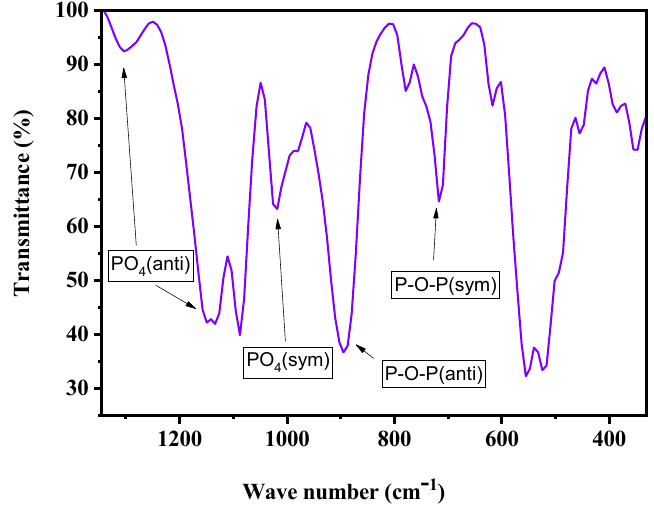
Figure 3. FT-IR spectrum of Na 2 CaP 2 O 7 . The morphology of the Na 2 CaP 2 O 7 surface was elucidated by scanning electron microscopy (SEM, Figure 4). Na 2 CaP 2 O 7 has a homogeneous microstructure that contains layers of various sizes and forms.